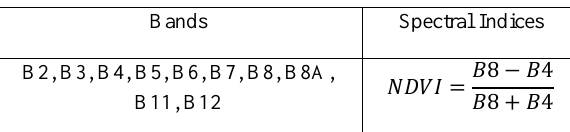
Figure 1 . The location of the study area of the Avalon (RGB composite of Sentinel-2 images).